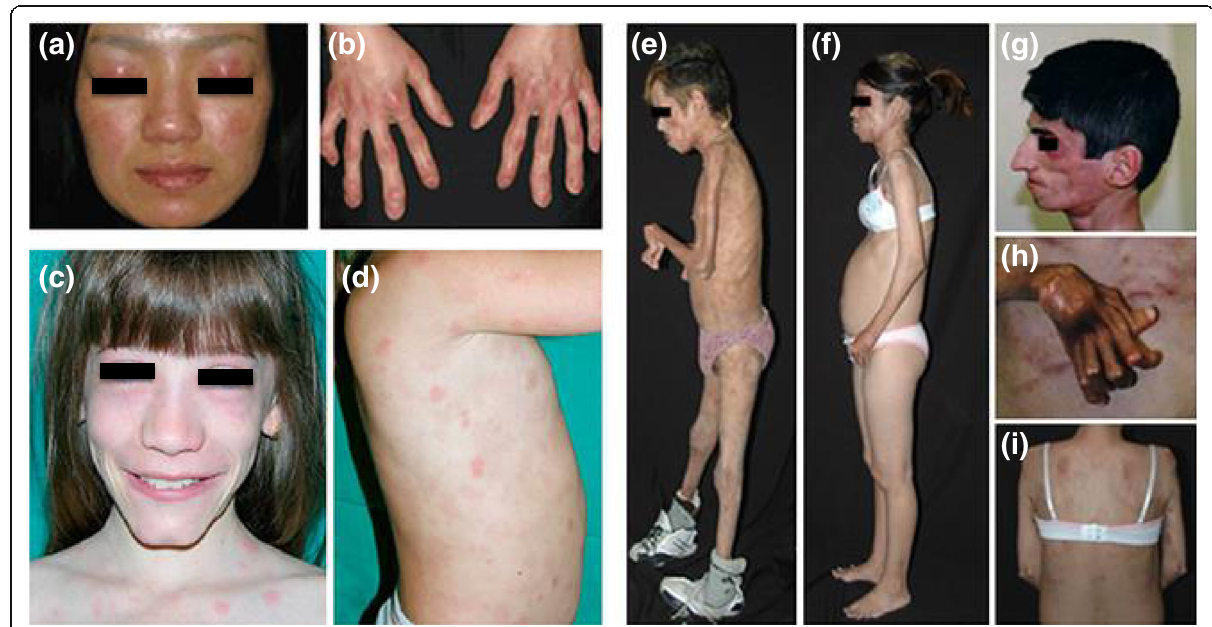
Fig. 1 Clinical features of PRAASs. a , b NNS. c , d CANDLE syndrome. e – i JMP syndrome cases. (Reprinted with permission; McDermott et al . [13])